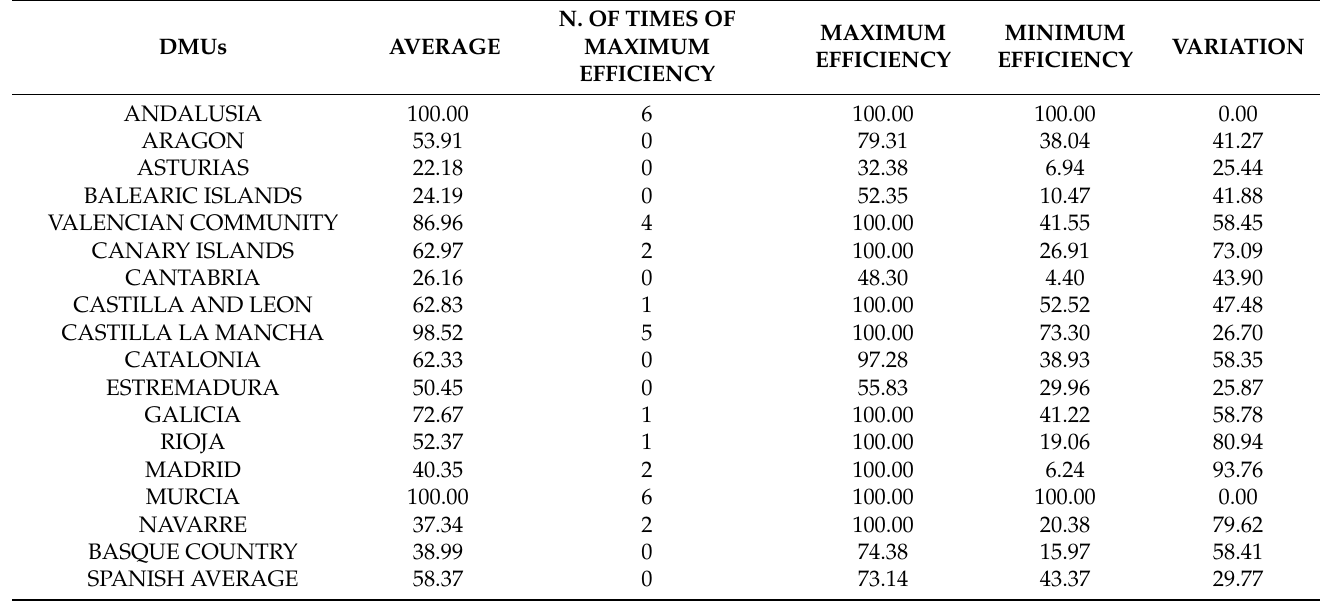
Table 8. Summary of efficiency indicators for the period of 2014–2019 (Source: Own elaboration.).